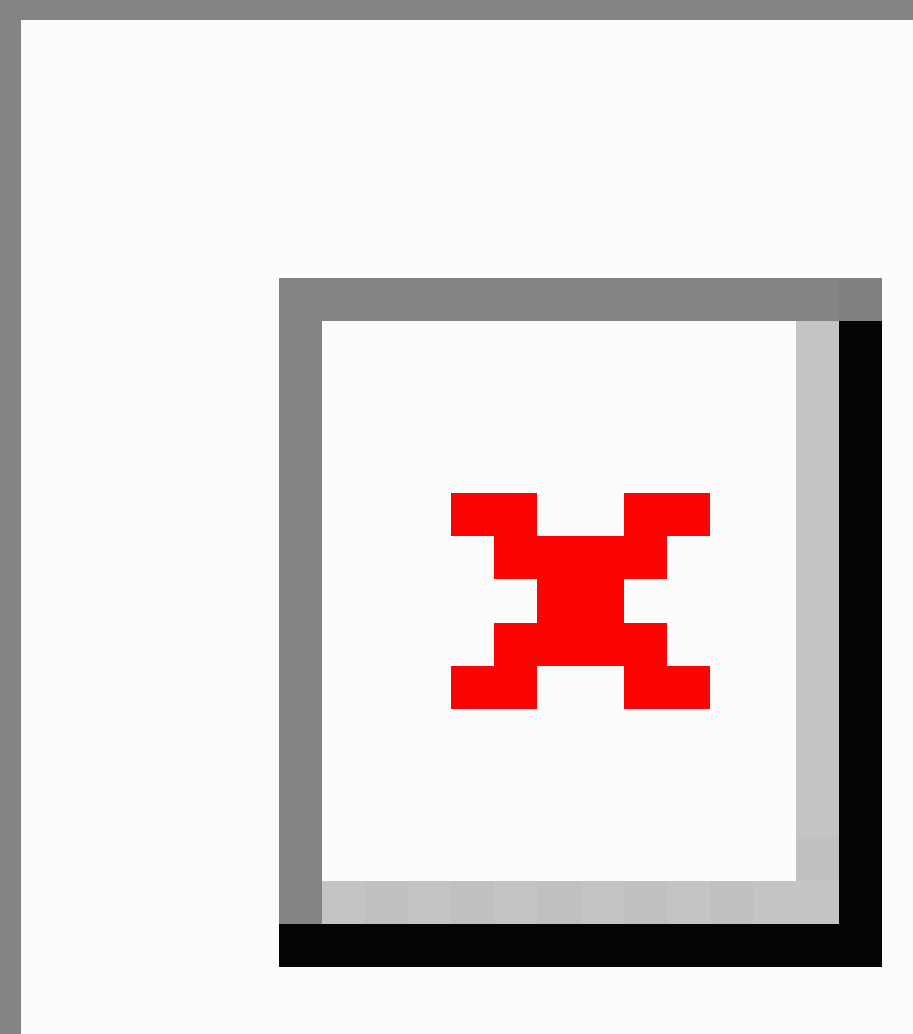
Figure 3. Thematic map of opinions and reasons given by